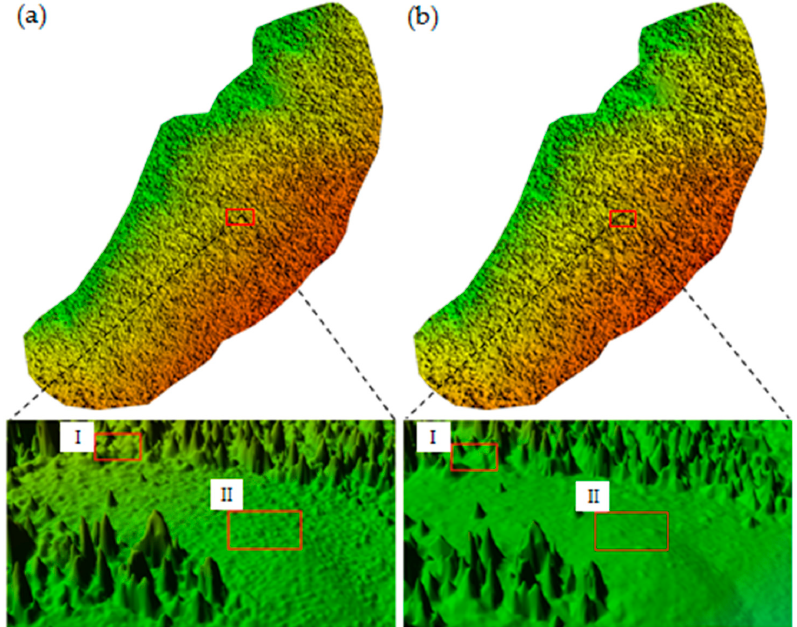
Figure 8. Comparison between the original DSM and the DSM with low vegetation removed.